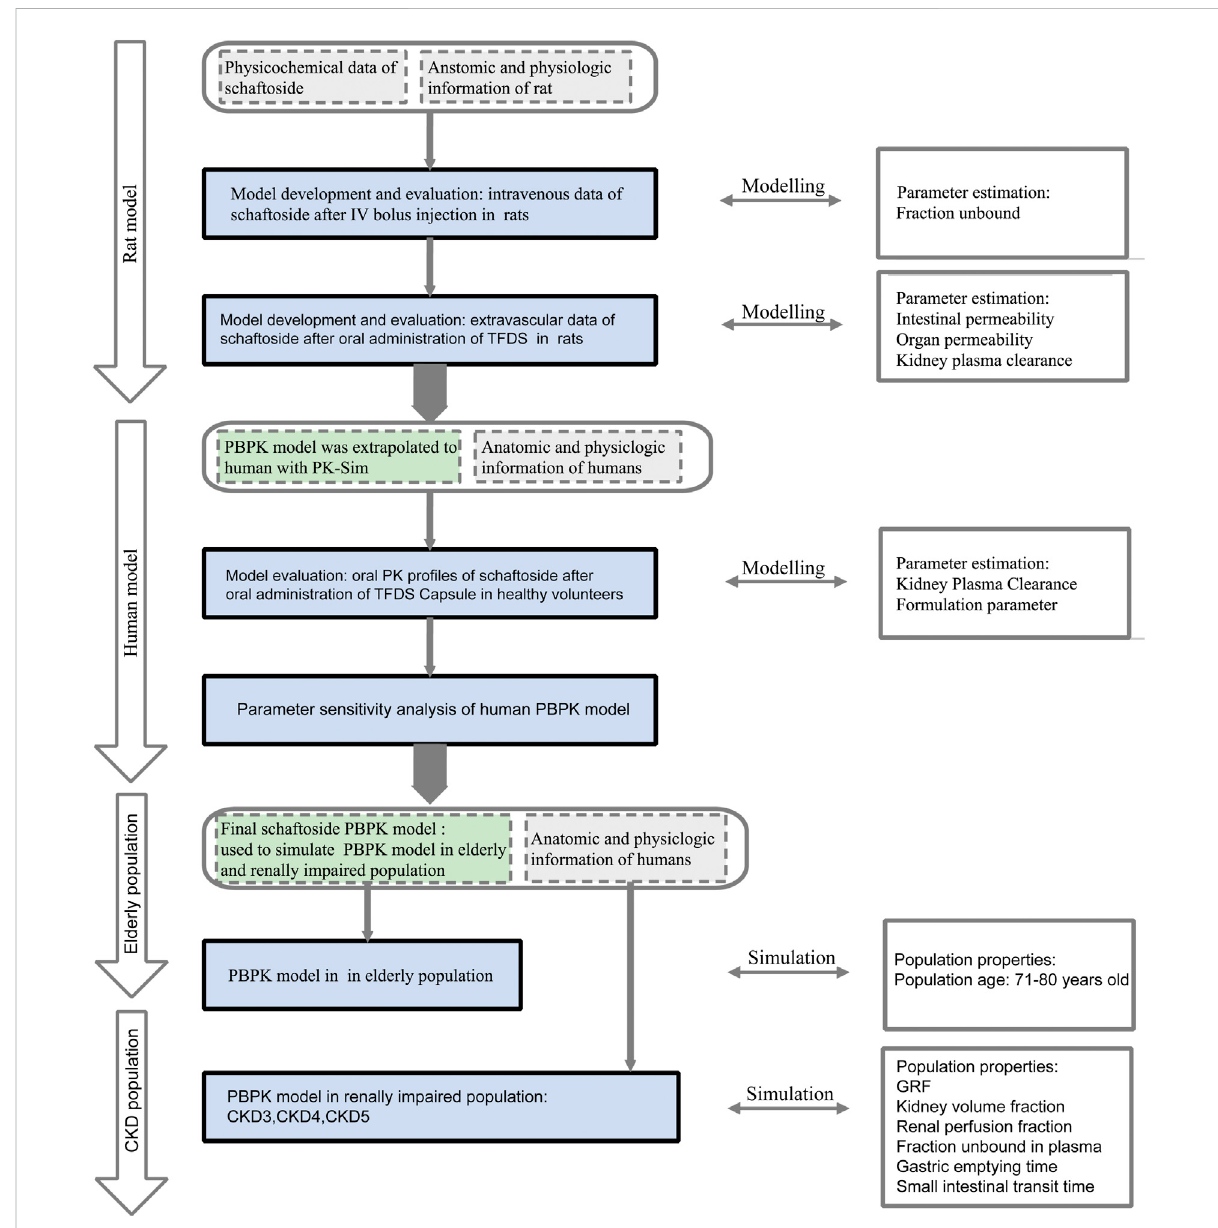
FIGURE 1 Schaftoside PBPK model-building work fl ow in rats and humans after oral administration of TFDS. The overall scheme included development, veri fi cation, and